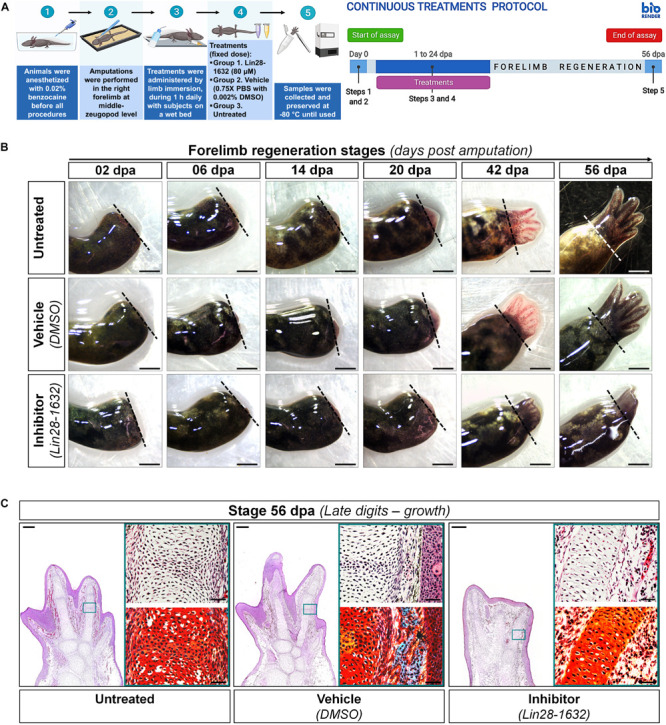
Phenotypic effects induced after long-term functional inhibition of Lin28 during limb regeneration. (A) Schematic diagram describing the protocol of continuous treatments implemented; on the left side, the general strategy followed is shown, and on the right side, the temporary management schedule during limb regeneration process. Created with BioRender. (B) Morphological changes registered after application of distinct treatments assayed at the end of regeneration. Dotted lines indicate the amputation site. Scale bars: 1 mm. (C) Histological sections at 56 dpa to analyze changes in the architecture and organization of tissues through H&E staining, after diverse treatments applied. The upper right panel displays a close-up of a representative region, and the lower right panel a similar region with a differential staining for connective tissue. Scale bars: 500 and 50 μm, respectively.